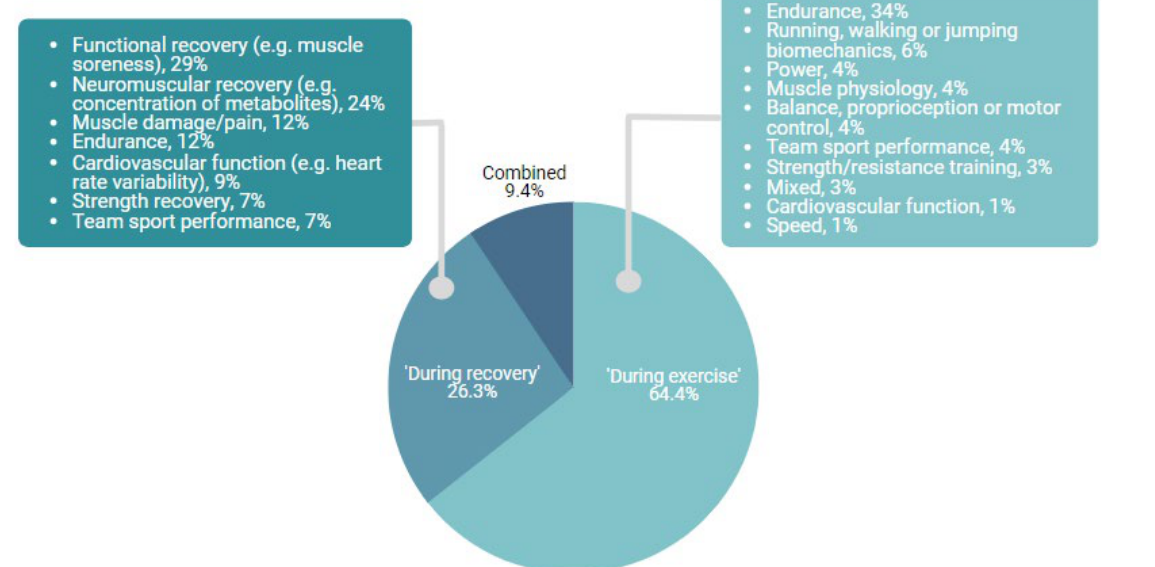
Figure 1. Proportion of included articles that were ‘during exercise’, ‘during recovery’ and of a combined design. Primary recovery outcome ( left ) and primary performance outcome ( right ) of the included studies is illustrated.